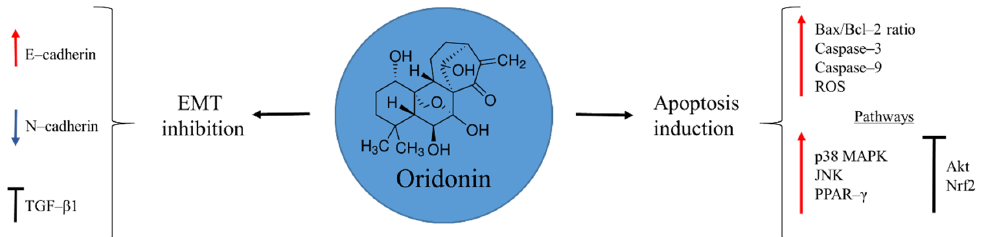
Figure 1. Oridonin in osteosarcoma